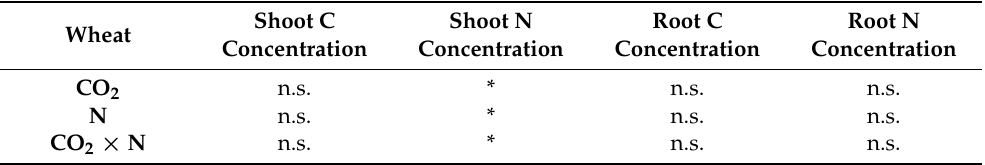
Table 8. Two-factor ANOVA analyses for C and N concentration in wheat seedlings. Shoot C Shoot N Root C Root N Wheat Concentration Concentration Concentration Concentration CO 2